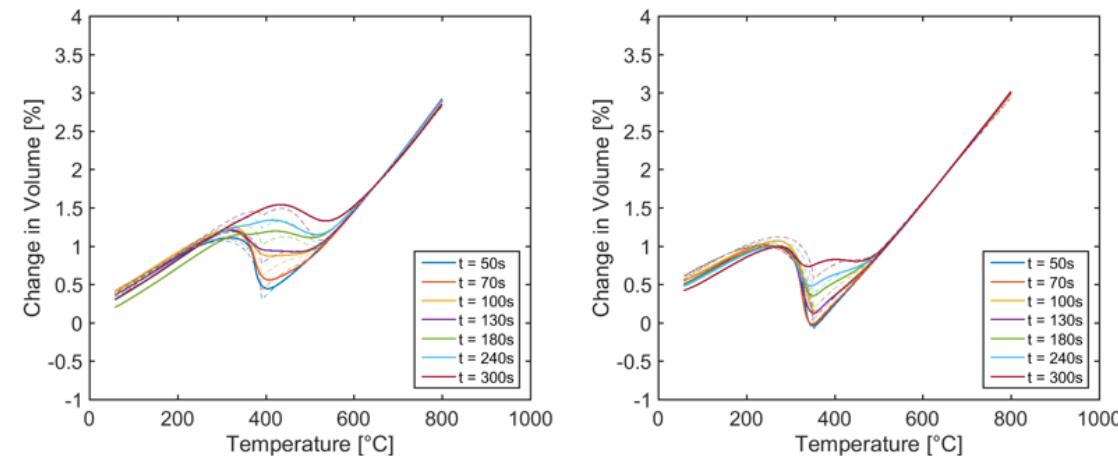
Figure 4. Comparison of the results from the simulation ( dash lines ) and the experiment ( solid lines ) for the elongation behavior as a function of cooling time and C-content ( left : 0.21%, right : 0.281%) for the compromise model [23].